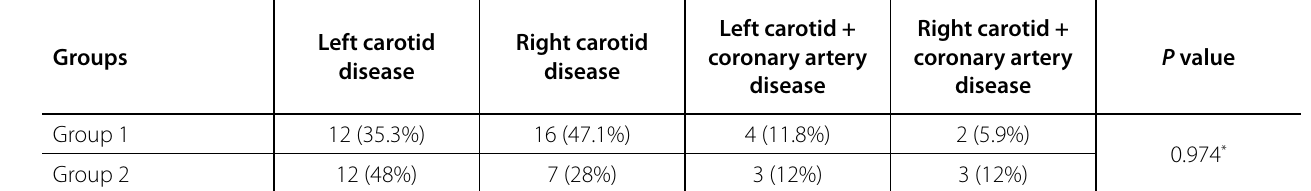
Table 2. Laterality.